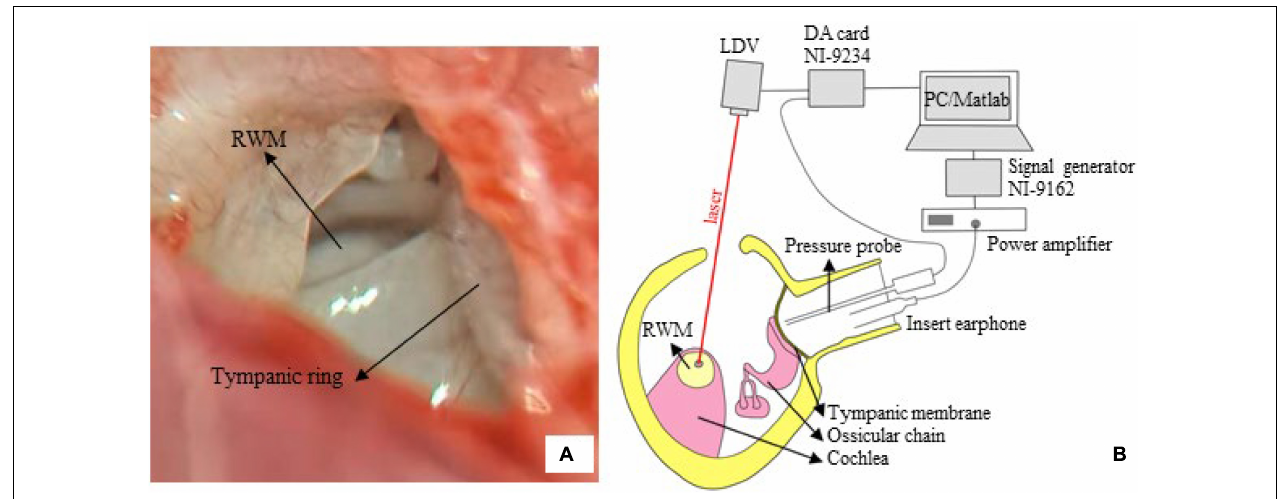
FIGURE 2 | The LDV measurement. (A) The surgical exposure was photographed via a dissecting microscope. The tympanic ring and round window membrane (RWM), with a radius of 0.5–0.6 mm, are seen from the opened middle ear cavity (right ear of tested guinea pig). (B) A sketch of the measurement system. The RWM velocity was measured via a compact LDV, and the signal was acquired by an AD card (NI-9234) and analyzed by an in-house MATLAB program.